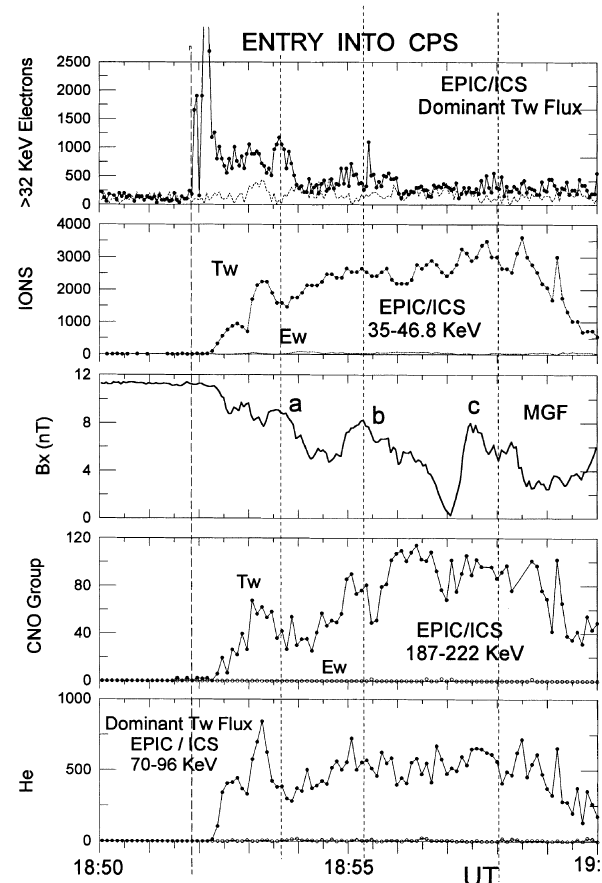
Fig. 7. The GEOTAIL transition from the south to the north lobe magnetic field structure ( central panel , B component) is associated Fig. 8. Final entry into the plasma sheet with obvious normal velocity x with almost isotropic >32-keV electron fluxes ( first panel ). The dispersion e(cid:128)ect. The energetic electrons stream tailward at the PSBL dominant Earthward fluxes of the 35–46.8-keV ions ( second panel ), region ( first panel ), while all the other ions show peak fluxes at inner the 166-187-keV CNO group ions ( fourth panel ) and 7.5–230-keV/e layers of the plasma sheet. The three local maxima marked as (a), (b), alphas ( bottom panel ) are apparent. The electrons do not display peak and (c) along the magnetic field trace ( third panel ) correspond to fluxes at the PSBLs higher and more anisotropic energetic